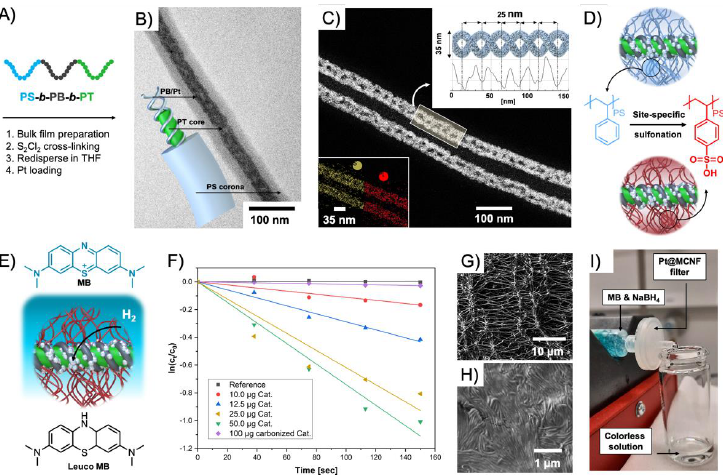
Figure 7. Polystyrene- block -polybutadiene- block -poly( tert -butyl methacrylate) (PS- b -PB- b -PT) template for organic/inorganic Pt hybrids . ( A ) Nanostructure fabrication process. ( B ) TEM of multicompartment nanofiber with Pt double helix and PS corona. ( C ) STEM of Pt double helix, grey scale analysis of the marked areas, and EDX analysis (yellow: S; red: Pt). ( D ) Scheme of PS sulfonation to PSS. ( E ) Scheme of the catalytic degradation of MB to Leuco MB. ( F ) Ln( c t / c 0 ) vs. time without catalyst (black), c cat = 10 mg·L −1 (red), 12.5 mg·L −1 (blue), 25 mg·L −1 (yellow), and 50 mg·L −1 (green); reference sample Pt/C at 100 mg·L −1 (purple). Initial concentrations are: [MB] = 2.0 × 10 −5 м, [NaBH 4 ] = 2.0 × 10 −2 м. ( G ) SEM image of 0.45 µm PTFE syringe filter and Pt@MCNFs-coated filter surface ( H ). ( I ) Flow set-up to catalyze MB in water using modified syringe filter at a flow rate of 1 mL · h − 1 . Adapted with permission of [93]. Copyright 2020 American Chemical